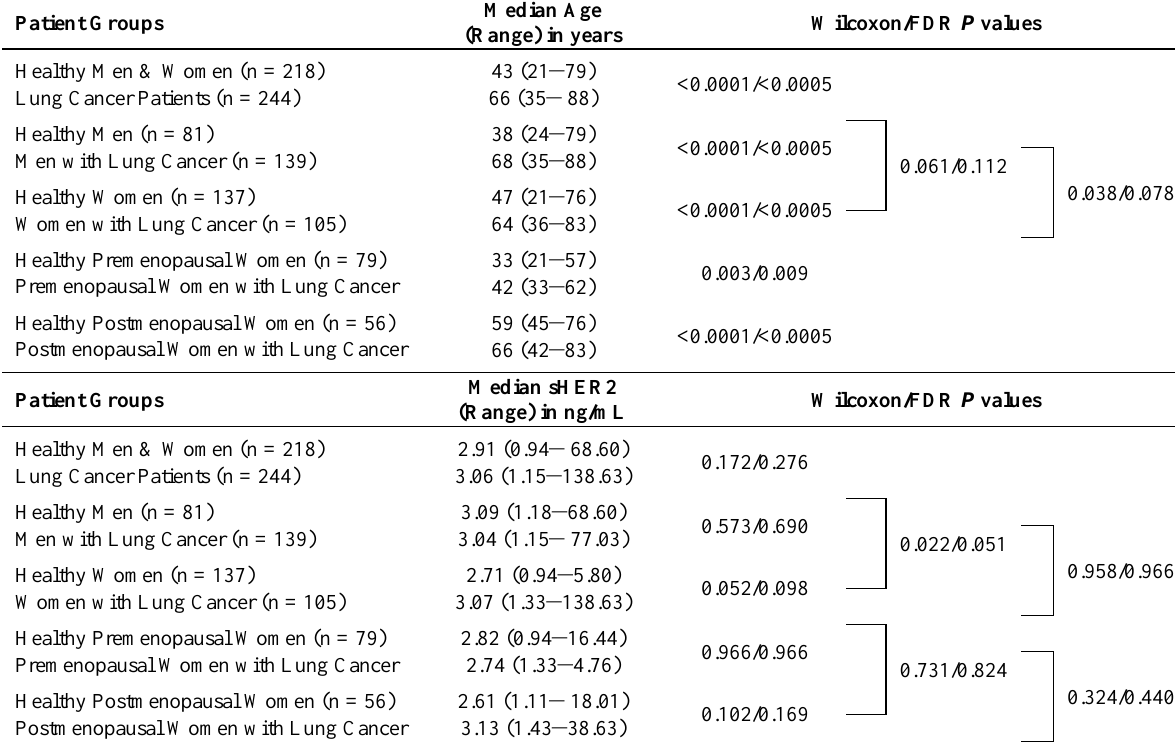
Table 1. Comparison of age and serum concentrations of soluble human epidermal growth factor receptor 2 (sHER2) in healthy controls vs. lung cancer cases. Age and serum sHER2 concentrations are compared between healthy men and women ( i.e ., controls) vs. patients with lung cancer by gender, and by menopausal status among healthy women.